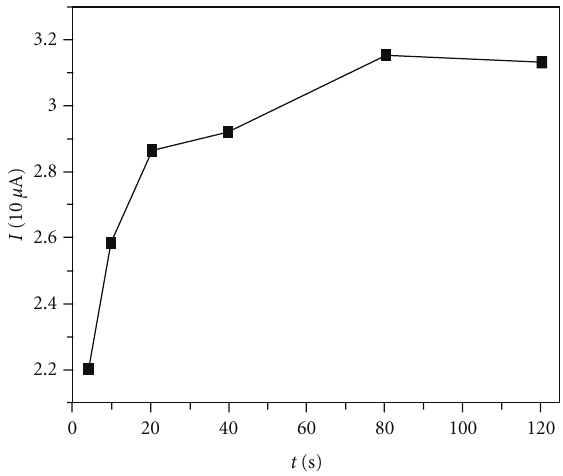
Figure 7: E ff ect of the accumulation time on the peak current in pH 6.0 PB solution containing 5.0 × 10 − 7 molL − 1 parathion. Scan rate: 100mVs − 1 .